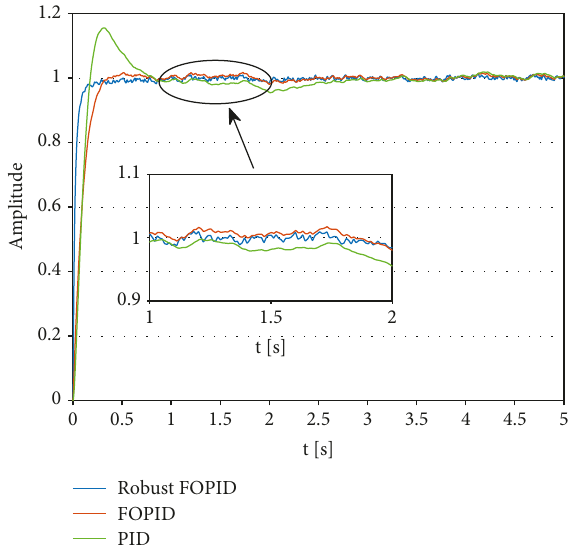
Figure 12: Step response comparison of G